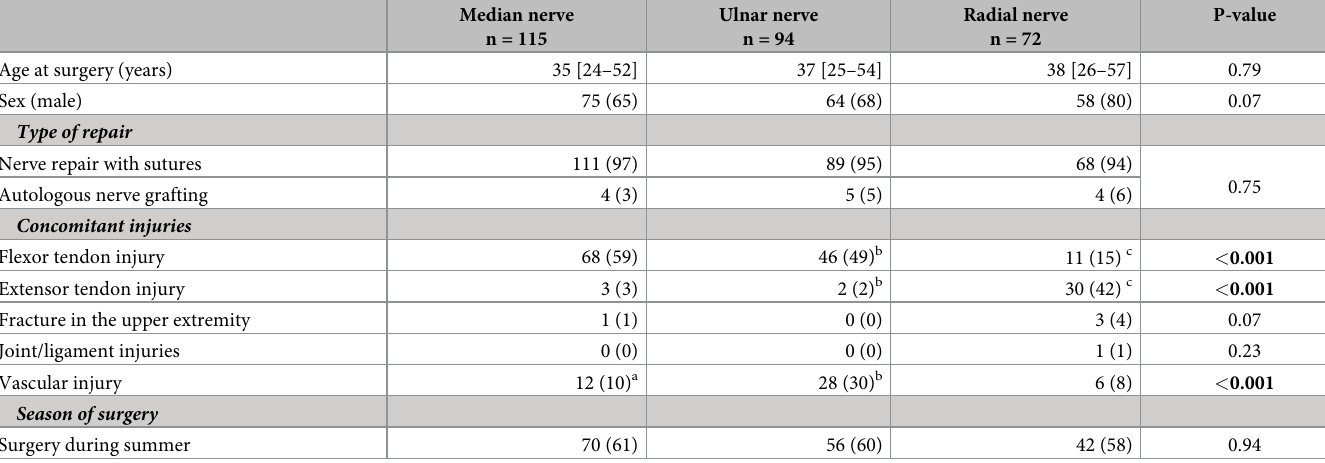
Table 1. Baseline characteristics of individuals treated with repair or reconstruction of a major nerve trunk injury in the upper